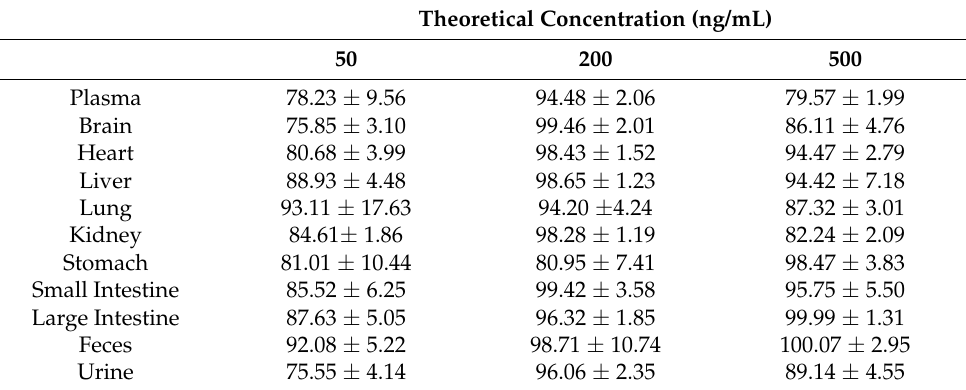
Table 2. Extract recoveries (%) of erinacine A in rat plasma and tissues.